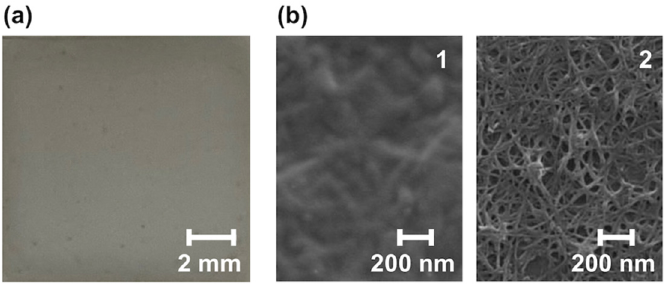
Figure 5. ( a ) Photograph of a PC 56 T 44 /SWCNT composite film formed on a substrate. ( b )